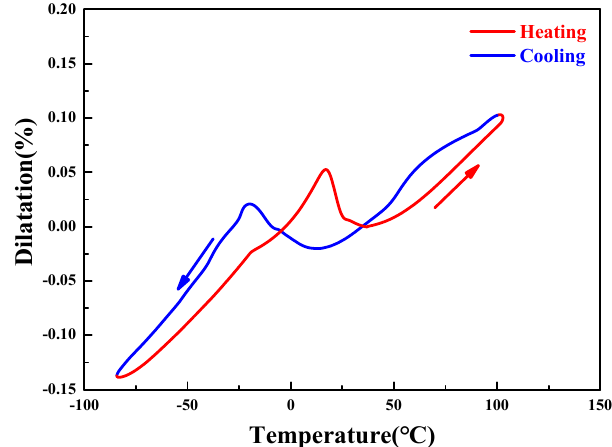
Figure 10. The thermal expansion measurement of the Cu 71.7 Al 18.1 Mn 10.2 alloy sample without pre-deformation process.